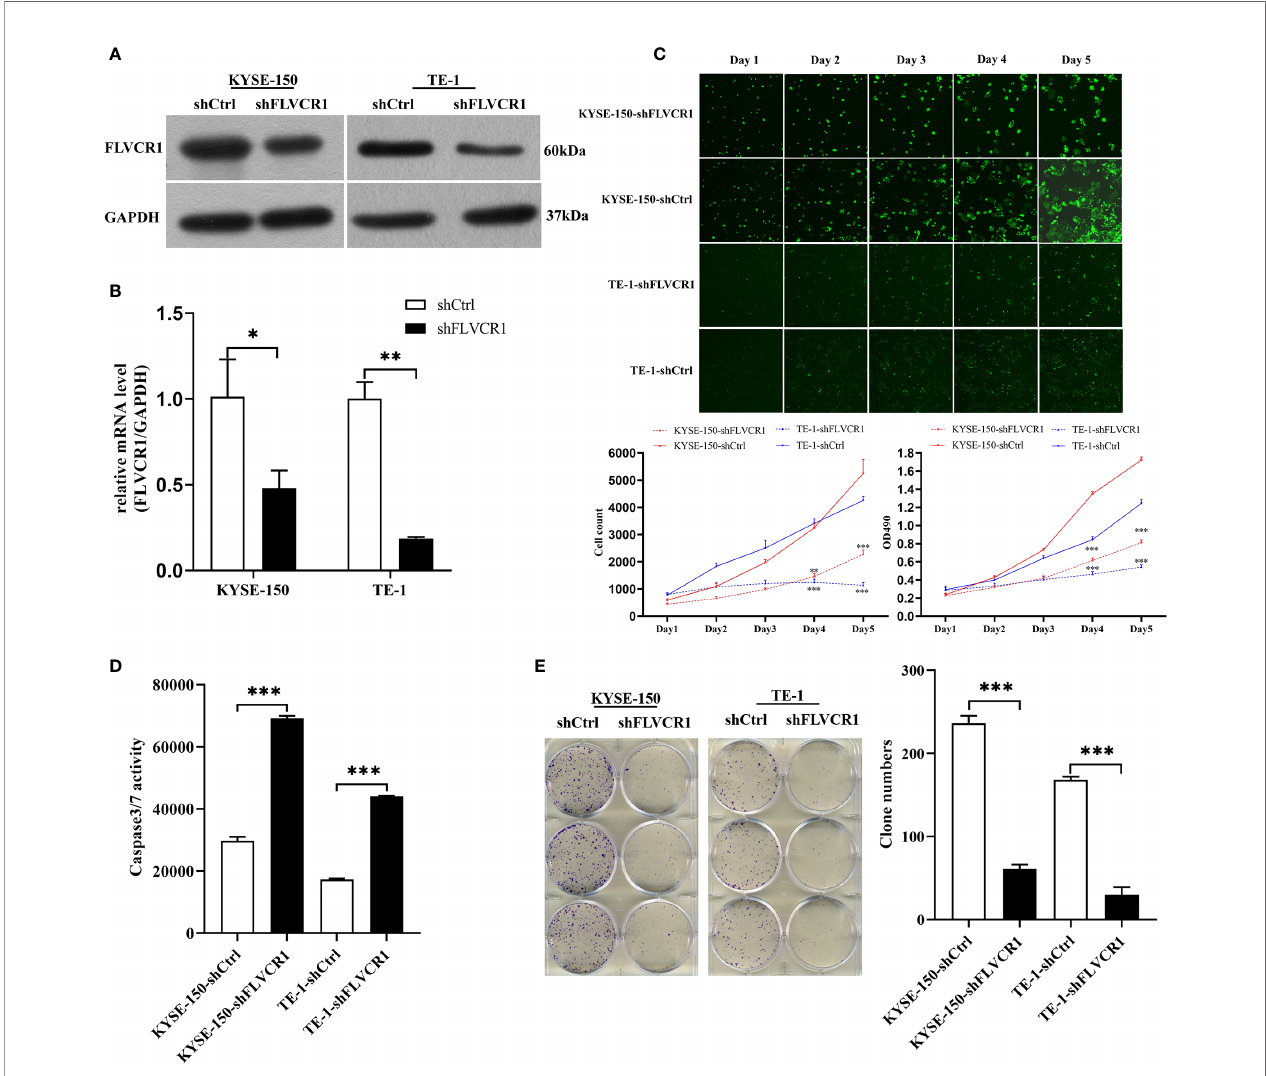
FIGURE 2 | The effect of FLVCR1 on ESCC cell proliferation and apoptosis in vitro. (A, B) Protein and mRNA expression of FLVCR1 was signi fi cantly downregulated in shFLVCR1 groups compared with shCtrl groups. (C) The proliferation rate of TE ‐ 1 and KYSE-150 cells was reduced by FLVCR1 knockdown, which was con fi rmed by the Celigo assay and MTT assay. (D) Knockdown of FLVCR1 remarkably enhanced caspase ‐ 3/7 activity in the shFLVCR1 groups. (E) FLVCR1 knockdown decreased the colon numbers in cells of shFLVCR1 groups compared to cells of shCtrl groups, respectively. Data were presented as the mean±SD of three separate experiments. *P < 0.05, **P < 0.01, ***P <